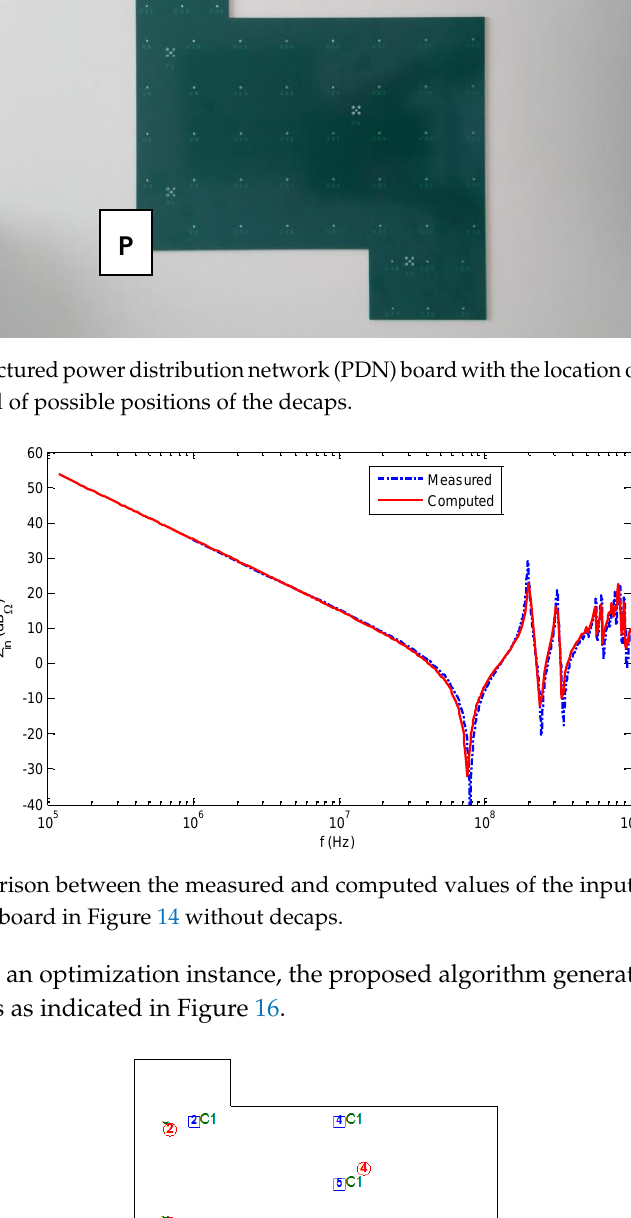
Figure 15. Comparison between the measured and computed values of the input impedance at the port P of the PDN board in Figure 14 without decaps.